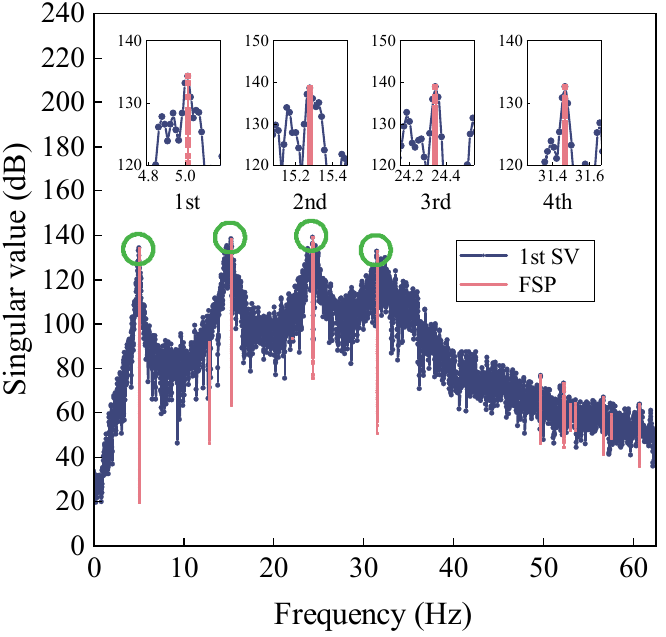
Figure 11. first-order singular value plots obtained from FSP-FDD. Figure 11. First-order singular value plots obtained from FSP-FDD.